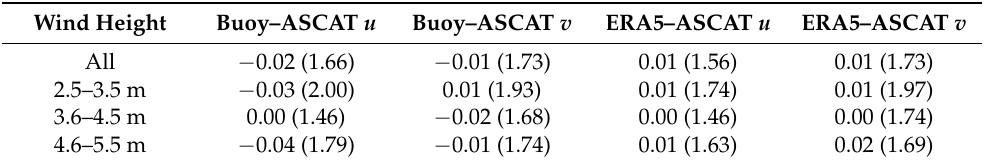
Figure 6. Triple collocation calibration bias corrections ( b ) of buoy U 10 S components calibrated with ASCAT winds as the standard for the full range of winds at the individual buoy level. The top subplot shows the calibration bias corrections for the u -component ( b ubuoy ) and the bottom is the v -component bias corrections ( b vbuoy ). Point shapes correspond to the buoy anemometer height ranges shown in the legend. Table 3. Average and standard deviation (in parenthesis) of wind component residual biases